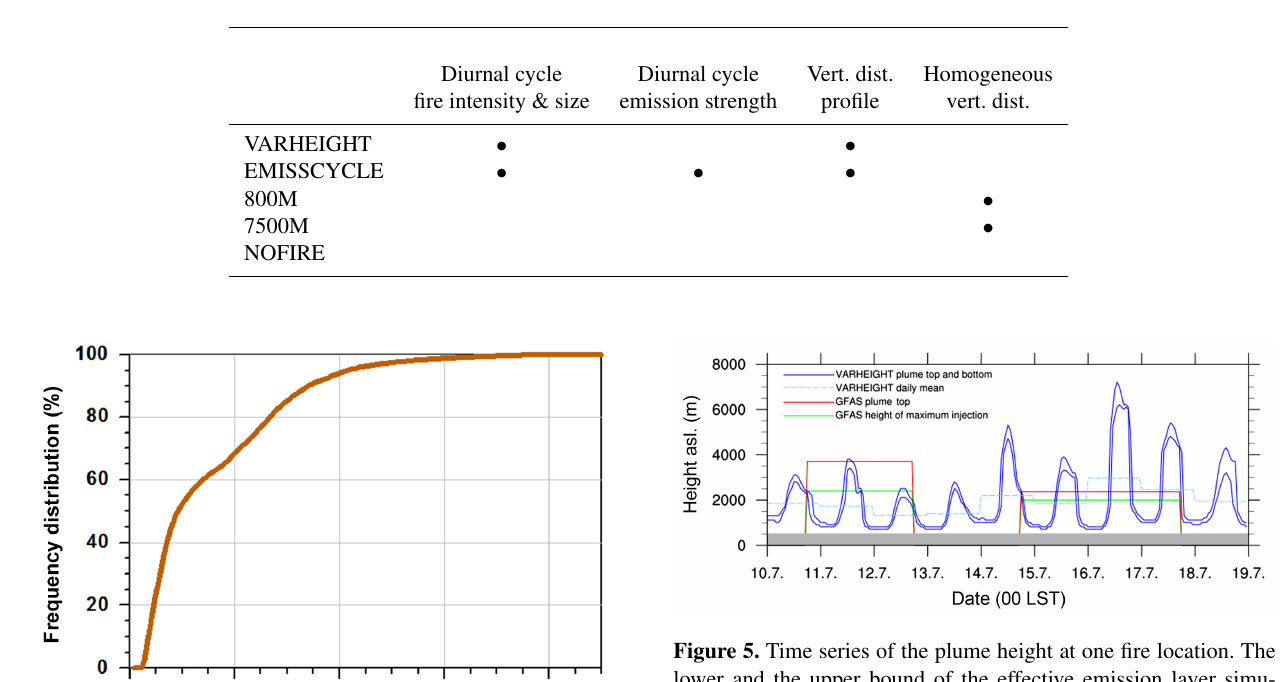
Table 3. Specification of the realized simulations.